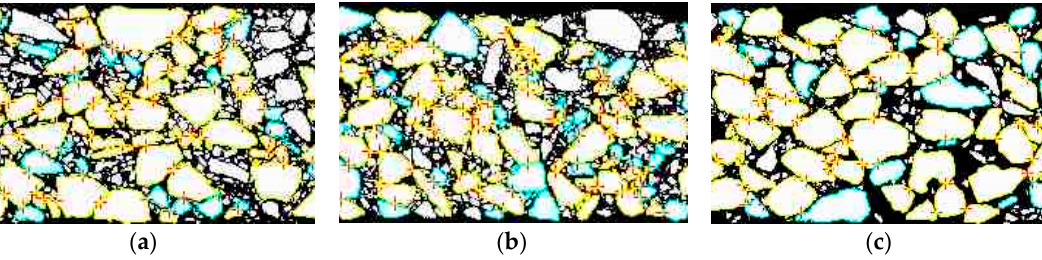
Figure 5. Mesoscopic contact characteristics of main skeleton before loading. ( a ) 70# asphalt AC-13C; ( b ) rock asphalt AC-13C; and ( c ) SMA-13. ( b ) rock asphalt AC-13C; and ( c )